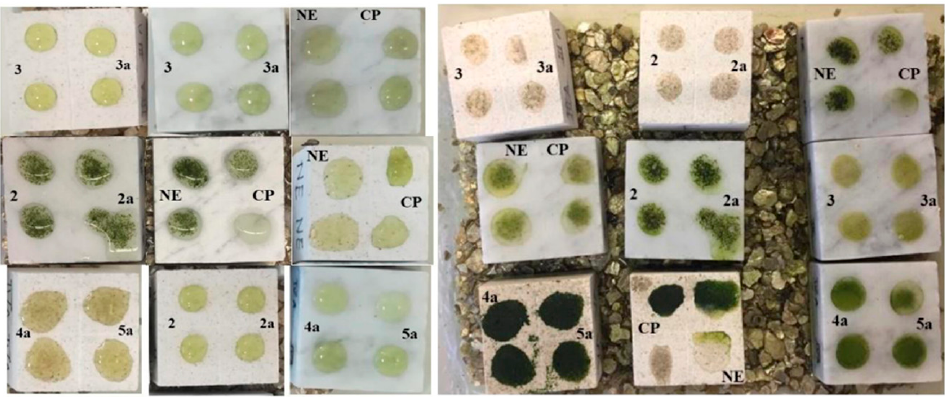
Figure 9. Novel ( a ) mono- and ( b ) germinal cholinium DBS based ILs. IL numbering is the same used for the antimicrobial test shown in Figure 8 and in the manuscript [De Leo et al., in prep.]. The tests have been carried out on a mixed stabilized microbial suspension (Gram + and Gram-, yeasts, hyphomycetes, and unicellular algae) on untreated (CP) stone probes (marble and calcarenite), treated with consolidant only (NanoEstel, NP) or treated with the consolidant and ILs, namely 2 , 2a , 3 , 3a , 4a , and 5a , respectively. As shown in Figure 10, after 90 days of incubation in laboratory conditions ◦ (22 C and at a constant illumination of ca. 1500 Lux), di ff erent behavior of the tested ILs was observed. In fact, 2 and 2a , and, especially, 3 and 3a , showed interesting antimicrobial colonization capabilities. On the contrary, 4a and 5a , promoted a remarkable microbial growth, even more pronounced than the untreated control sample. Such findings corroborate, once more, that is the IL lipophilicility that determines their bioactivity in that 3 and 3a, featuring longer alkyl chain lengths on the CH cation resulted in the most e ff ective ones.